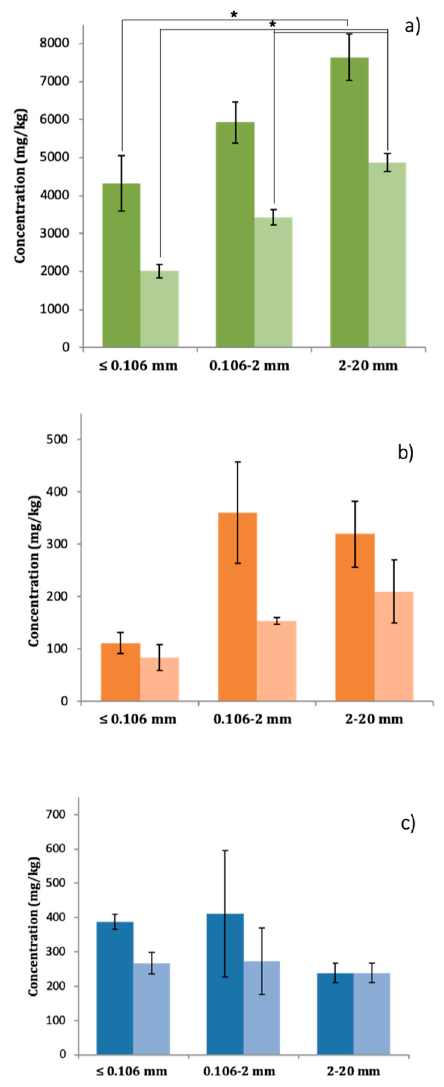
Figure 7. Histograms representing the concentration of asbestos in each grain size class of each sample: ( a ) serpentinite; ( b ) debris; and ( c ) soil. The darker columns represent the mean of the concentrations of the three replications calculated for each grain size class. The lighter columns represent the mean of the concentrations of the three replications calculated for each grain size class excluding the outlier fibers from the calculation. The black bars represent the standard deviation. Asterisks shown in figures indicate significant differences between groups (* = p < 0.05).